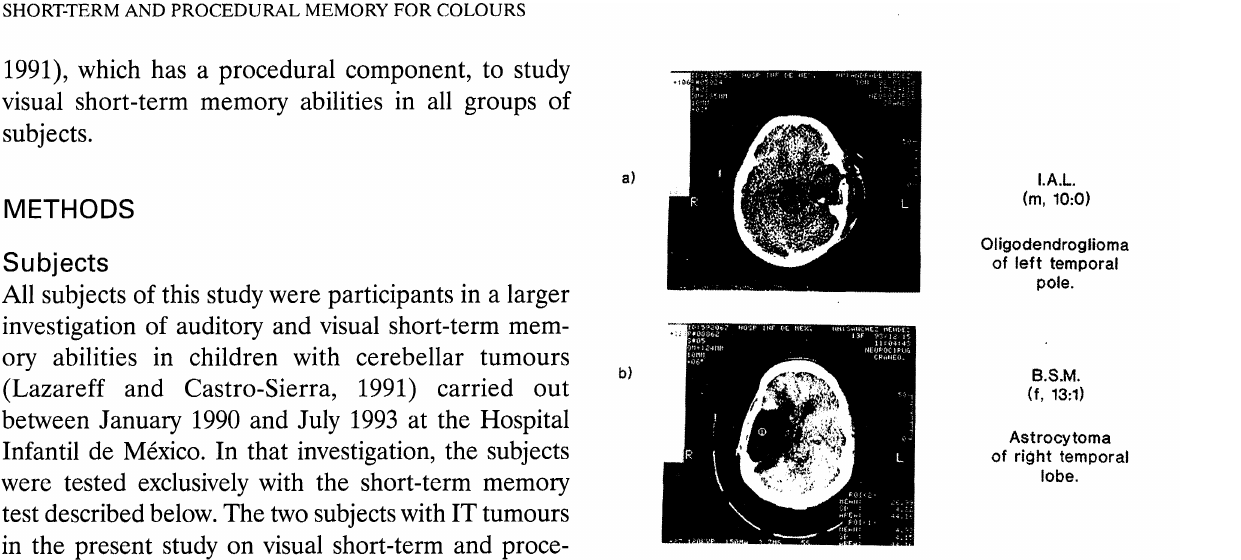
FIG.1. Post-surgical contrast axial tomography. L is left and R is right. (a) I.A.L. (male, 10 years 0 months). Note increased density in area of left temporal pole of the brain. (b) B.S.M. (female, 13 years 1 month). Note increased density in area including most of right inferior temporal lobe of the